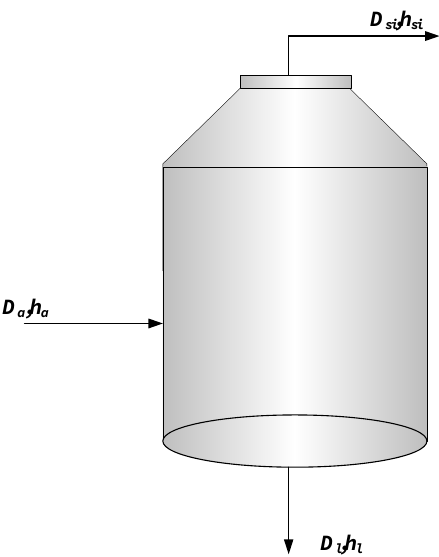
Figure 5. Structure of the flash tank.